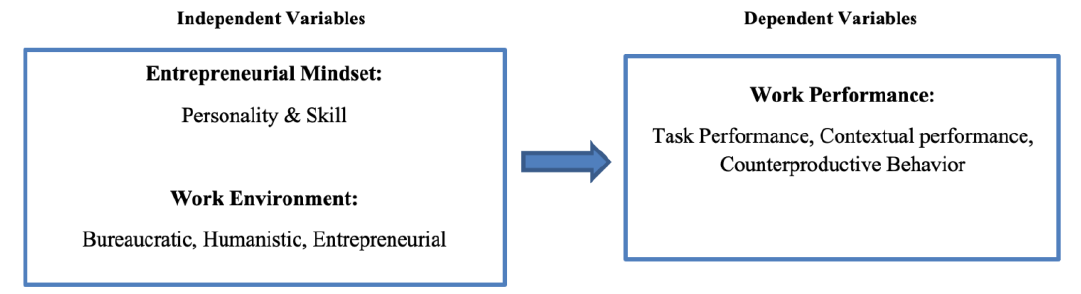
Figure 1: The conceptual framework reflects the correlation between the entrepreneurial mindset and work performance as mediated by the work environment; Source: Davis (2015), Abun, et.al (2021) and Koopmans, et.al (2012).